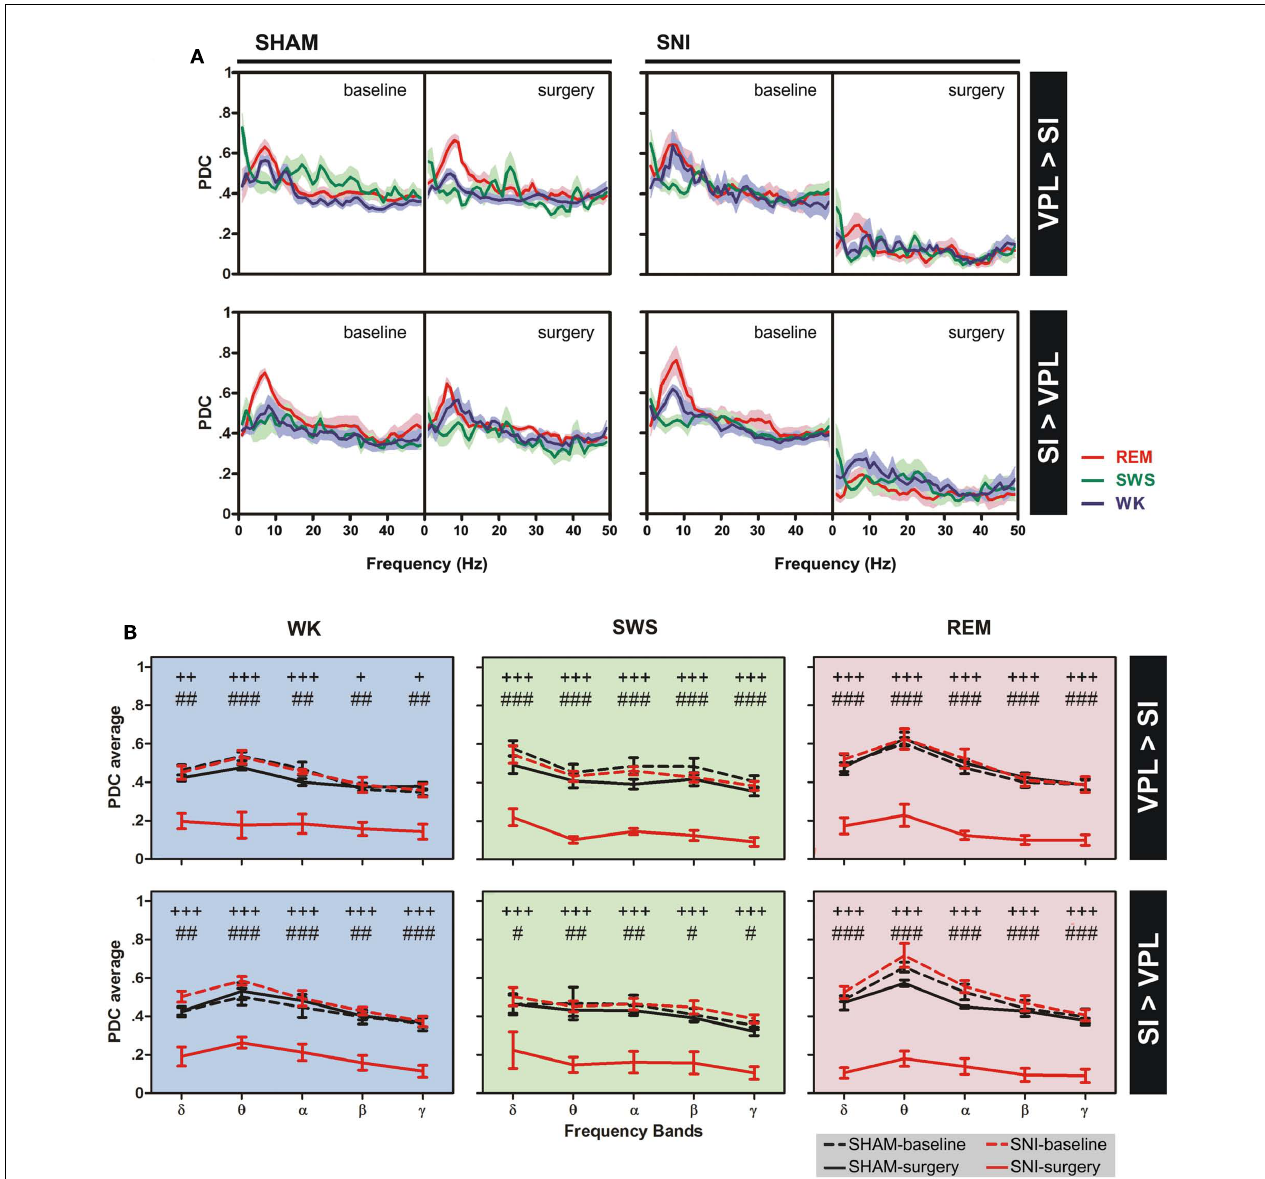
averaged PDC across frequency bands revealed a significant decrease of information flow for both directions at all frequency bands. Frequency bands: delta ( δ , 1–4Hz), theta ( θ , 4–9Hz), alpha ( α , 9–15Hz), beta ( β , 15–30Hz), and slow-gamma ( γ , 30–50Hz). Comparison of SNI-surgery groups in respect to SNI-baseline (plus symbols), and to SHAM-surgery (cardinal symbols).Values are expressed as mean ± SEM. + /# P < 0.0125, ++ /## P < 0.0025, +++ /### P < 0.0002 (Bonferroni test with corrected P